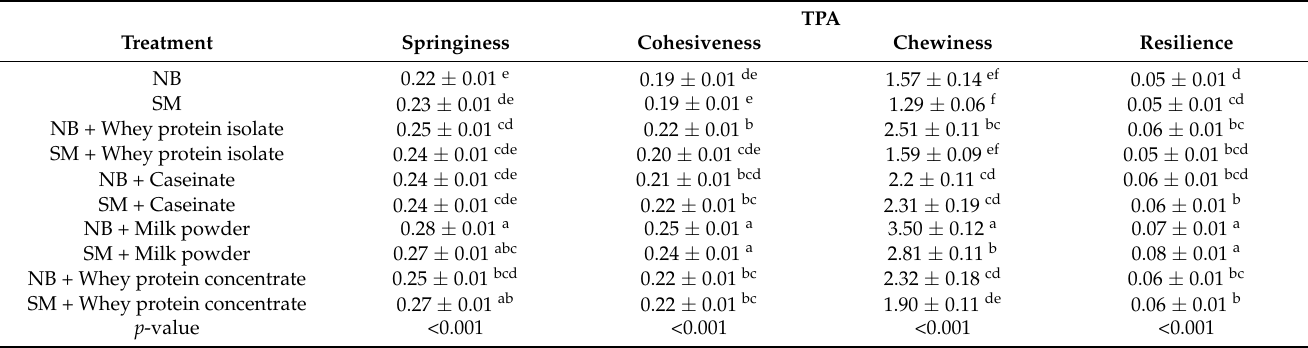
Figure 2. Hardness values for the minced normal breast (NB) chicken fillets and spaghetti meat (SM) samples, with and without dairy proteins (caseinate, whey protein concentrate, whey protein isolate, whole milk). a–e Means ( n = 18) followed by a different letter are significantly different ( p < 0.05). The stripes indicate SM samples; the bars show standard error. Table 1. Effects of the dairy protein treatments on the normal breast (NB) and spaghetti meat (SM) samples, with and without dairy proteins (caseinate, whey protein concentrate, whey protein isolate, whole milk).